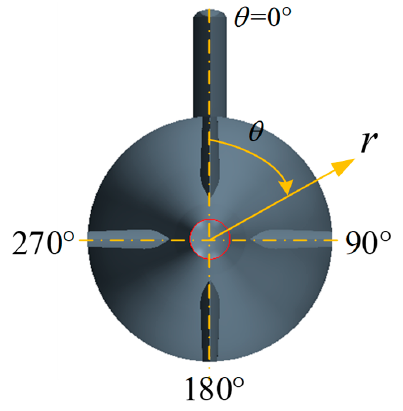
Figure 5. De fi nition of a wake angle. Figure 5. Definition of a wake angle.